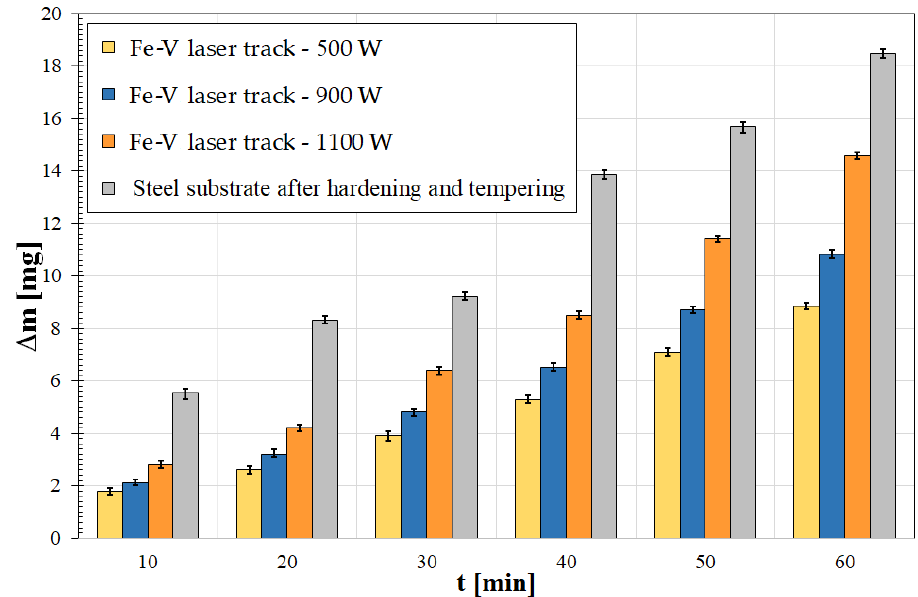
Figure 9. Results of wear resistance tests for iron–vanadium coatings produced using laser processing— 95% confidence interval .